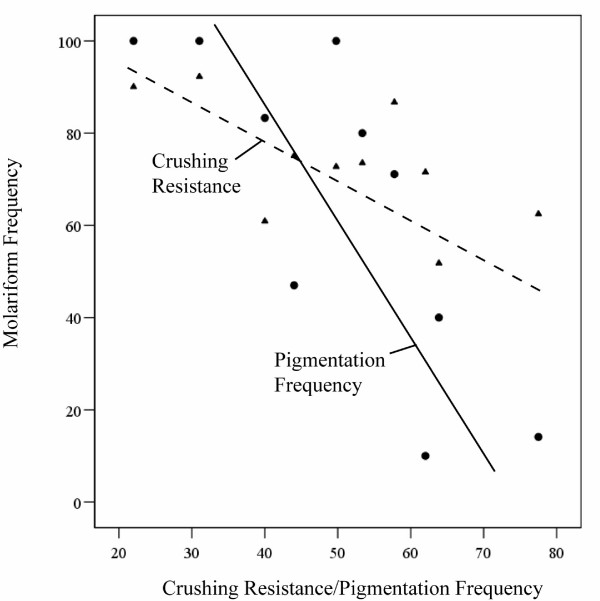
Relationship between frequency of molariform cichlids and both adjusted marginal mean crushing resistance (triangles and dashed line) and frequency of pigmented shells (circles and solid line).